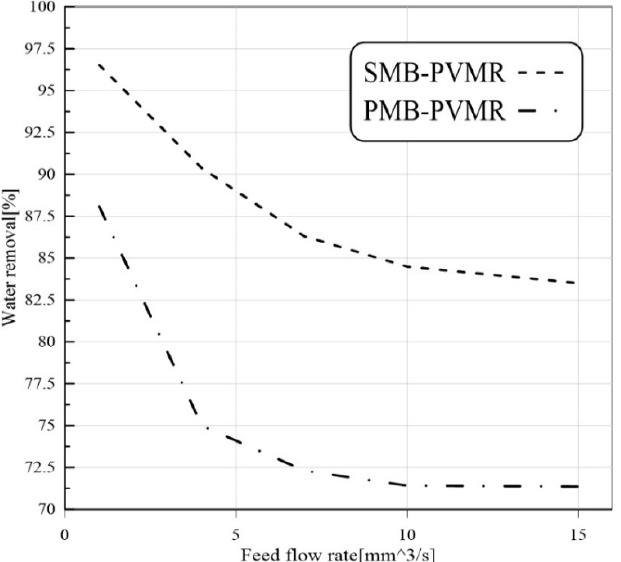
Figure 9. Comparison of water removal in MB-TR, PMB-PVMR, and SMB-PVMR based on variations in feed flow rate. Et/LA:1, temperature: 333 K, and W = 8.6 g.